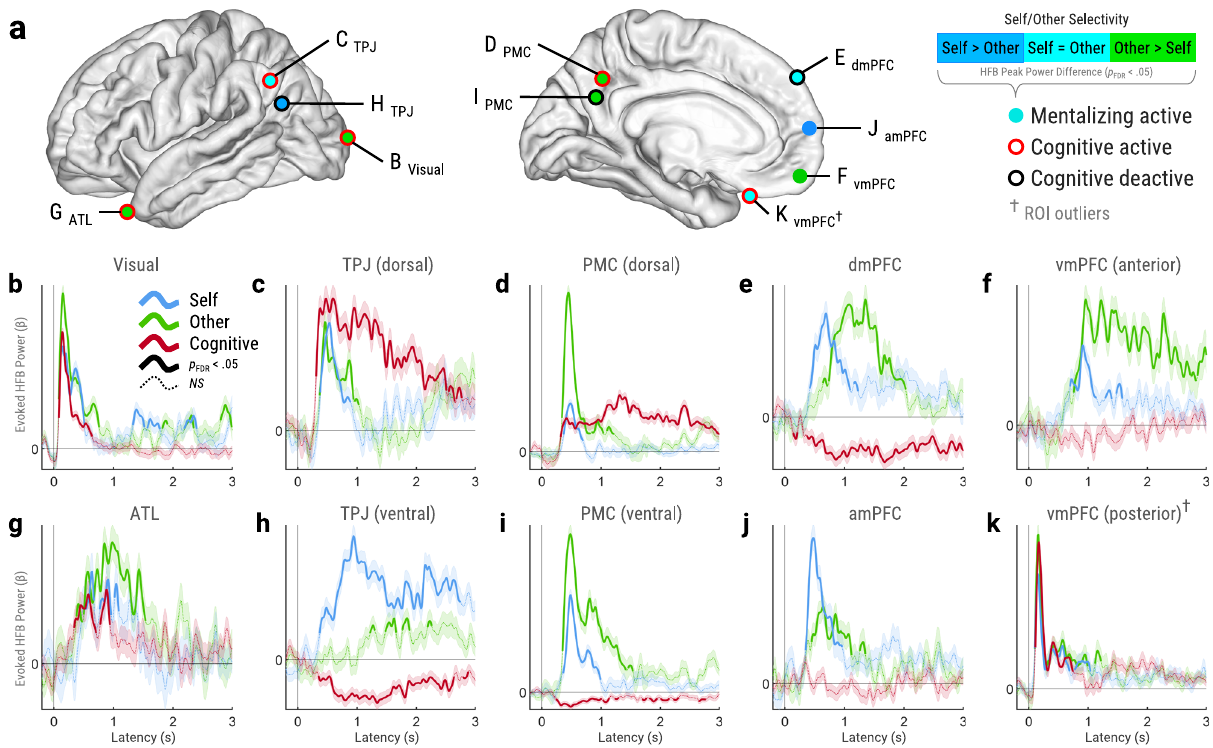
Fig. 2 Exemplar ROI sites. a Map of exemplar ROI sites, which were identi fi ed as mentalizing-active versus baseline in trial-averaged analysis (see Fig. 1f; p fi ll color indicates self/other selectivity, which was determined by comparing single-trial HFB peak FDR < .05, corrected across timepoints and sites). Circle power (see Fig. 1e) across mentalizing type via robust regression ( p FDR < 0.05, corrected across sites). Circle outline indicates signi fi cant HFB responses to the cognitive (arithmetic) task versus baseline ( p FDR < 0.05, corrected across timepoints and sites). b – k Trial-averaged timecourses of evoked HFB power ( β ) from exemplar sites in panel a . Thick solid lines indicate signi fi cant responses versus baseline ( p FDR < 0.05, corrected across timepoints and sites). Thin dashed lines indicate nonsigni fi cant ( NS ) responses. Shaded areas indicate standard error of β . † Excluded from ROI analyzes due to outlier thresholds (see Methods). Abbreviations : HFB = high-frequency broadband (70 ‒ 180 Hz). ROI = region-of-interest, Visual = visual cortex, ATL = anterior temporal lobe, TPJ = temporoparietal junction, PMC = posteromedial cortex, amPFC = anteromedial prefrontal cortex, dmPFC = dorsomedial prefrontal